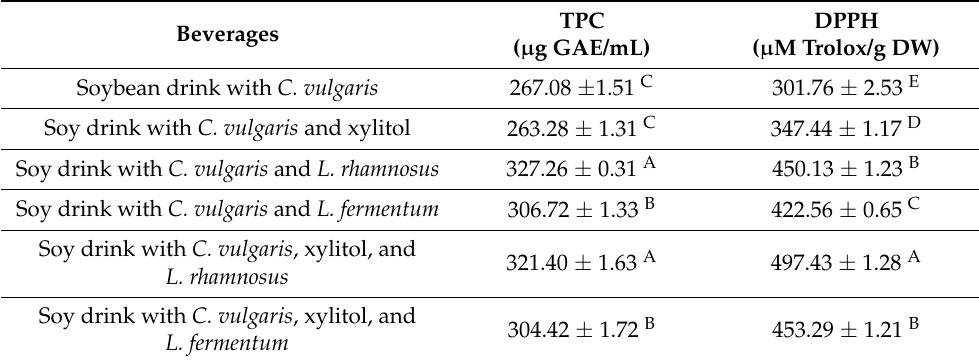
Table 1. Total phenolic content (TPC) and antioxidant activity (DPPH) of the beverage